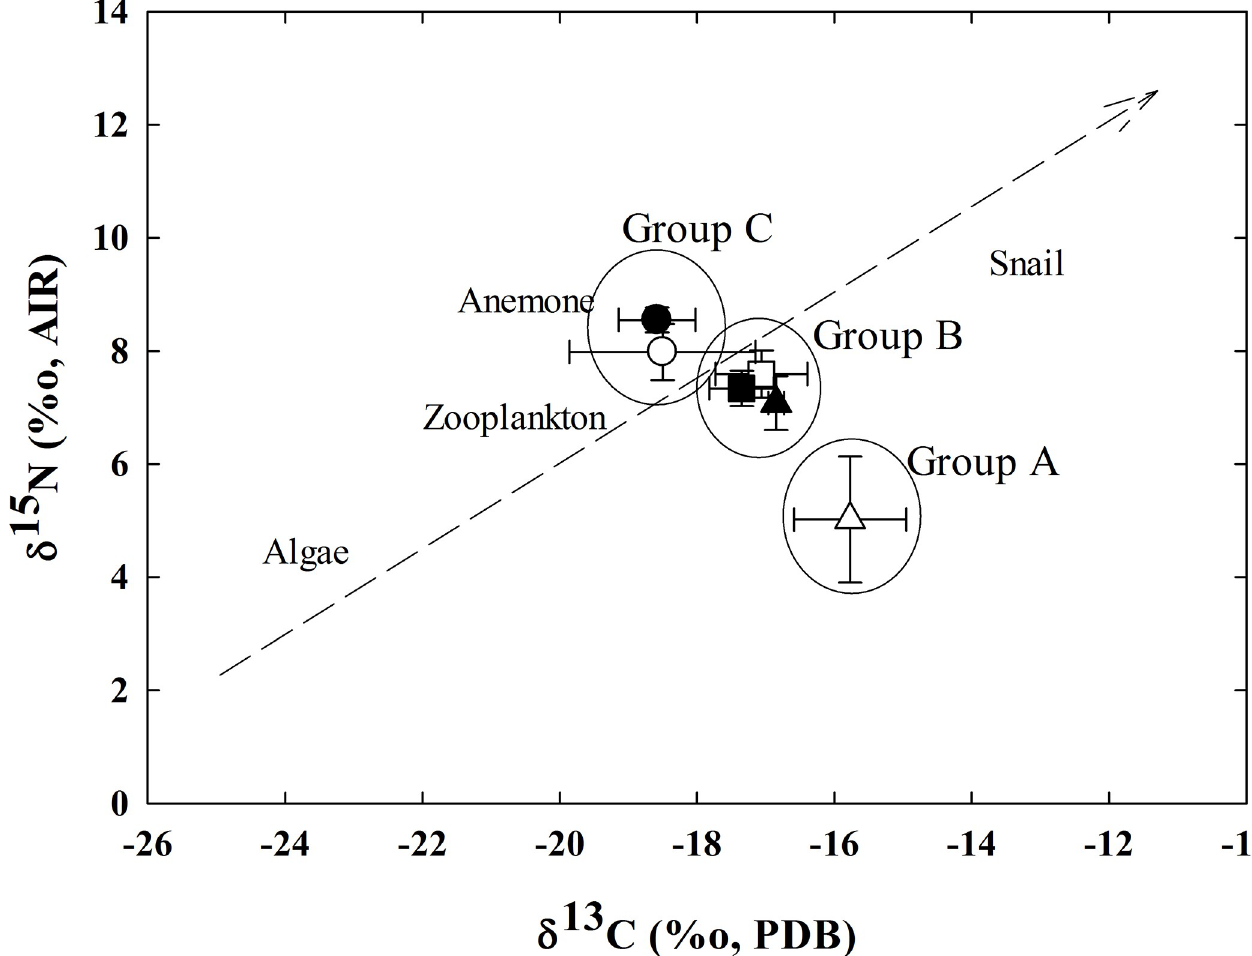
Fig 3. Distribution of isotopic signatures of carbon and nitrogen in organisms collected from the Kueishan hydrothermal field. The geometric marks indicate (mean ± SD) in X . testudinatus samples. Open: male; solid: female; triangle: samples from site ‘A’; square: samples from site ‘B’; circle: samples from site ‘C’.